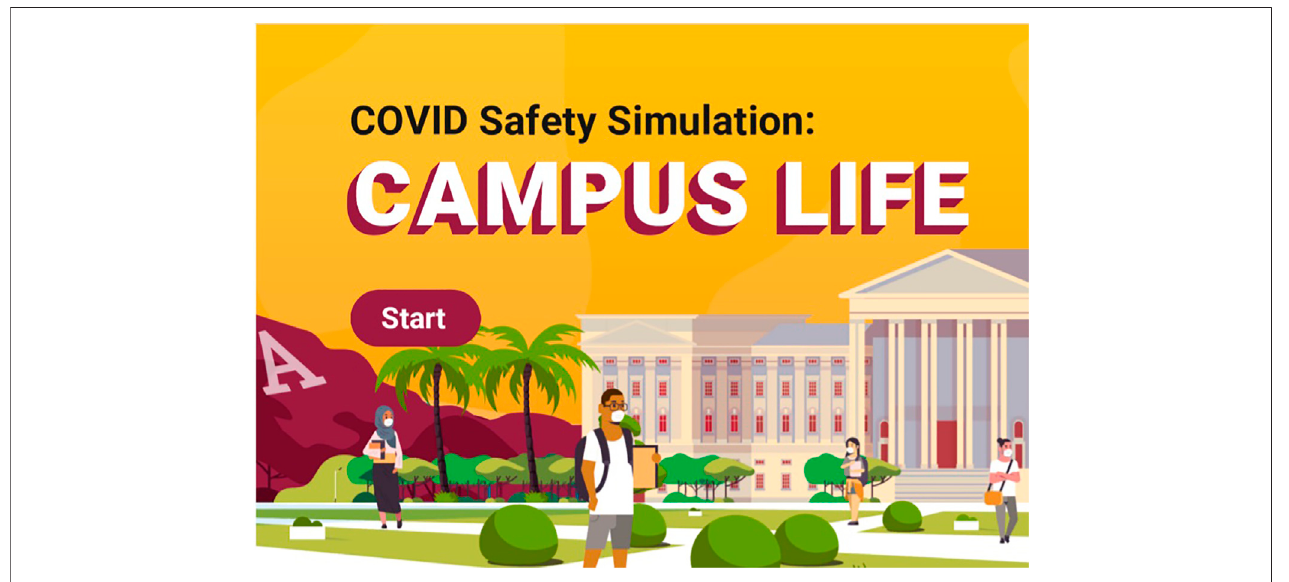
FIGURE 2 | Opening page for the new WebGL version of the CovidCampus